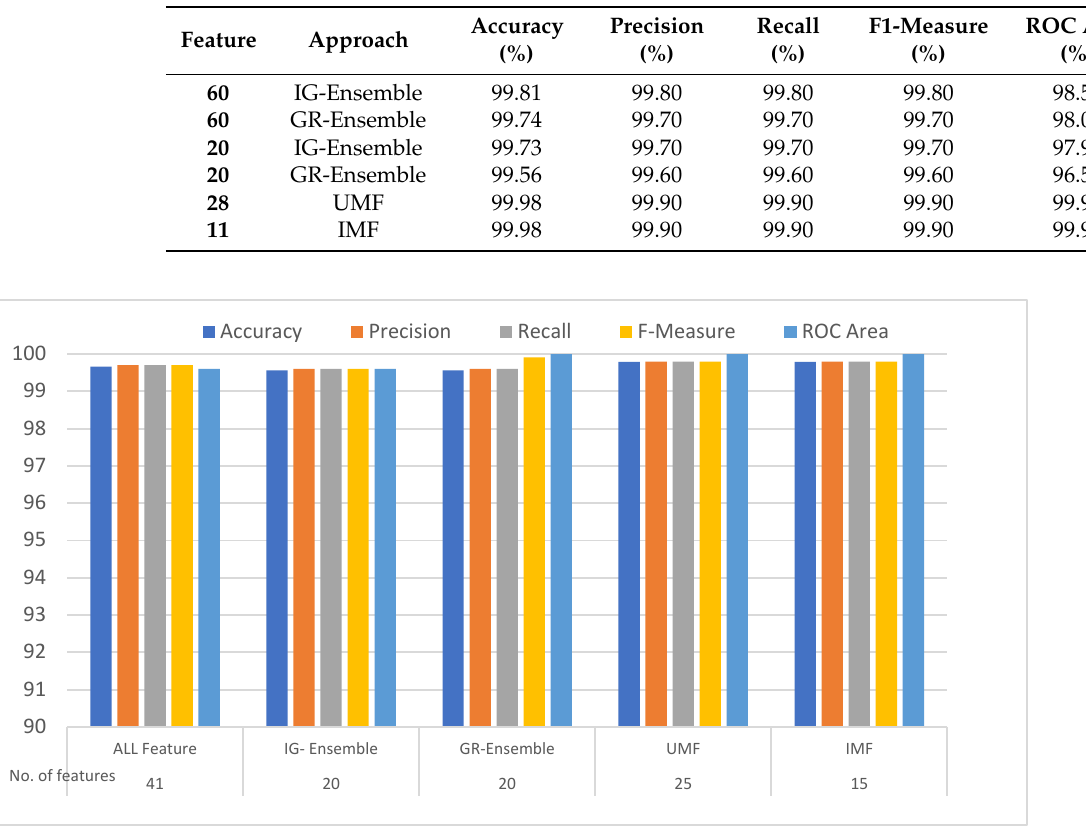
Figure 7. Graphical representation of performance metrics of NSL-KDD using ensemble with various selected features. Table 7. Performance metrics of NSL-KDD using ensemble with various selected features.